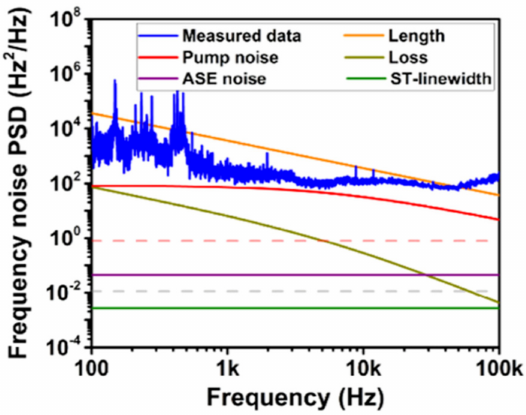
Figure 7. Comb-line noise PSD measured by DOH technique. Reprint with permission from [73]. Copyright 2020 Optical Society of